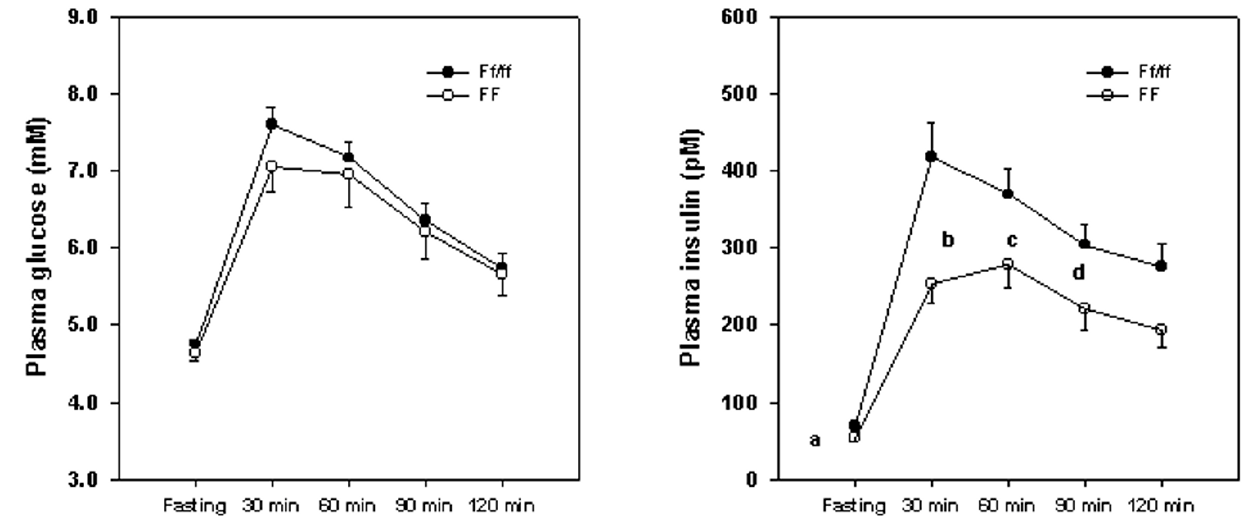
Figure 1 Plasma glucose and insulin levels during the oral glucose tolerance test by the FokI polymorphism at the vita- min D receptor gene locus. The data presents arithmetic means ± standard errors. The Ff/ff group is shown as the line with the solid dots and The FF group is shown as the line with open dots. The plasma insulin levels were different between the two groups at fasting (a, p=0.006), 30 (b, p=0.009), 60 (c, p=0.049) and 90 (d, p=0.041) minutes. The insulin areas under the curve were also different (p=0.009) between the two groups.